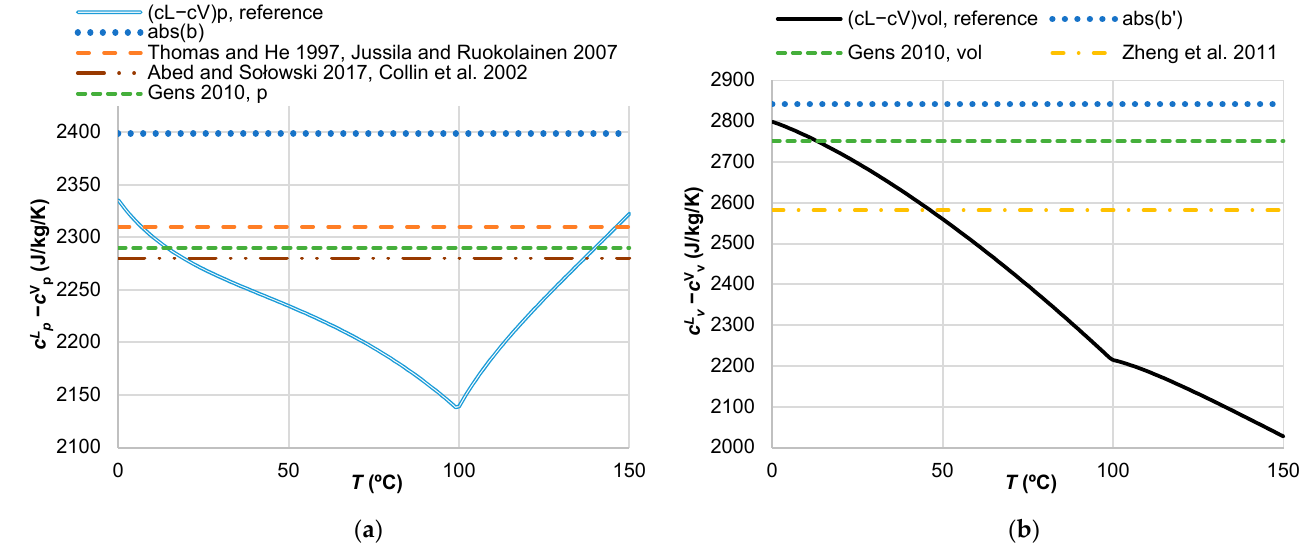
Figure 6. Difference in specific heat capacity between liquid water and vapour as a function of temperature. Solid lines: reference values [13] for ( a ) isobaric and ( b ) isochoric conditions; dotted and dashed lines: identified b and b (cid:48) coefficients and the literature values in Table 2